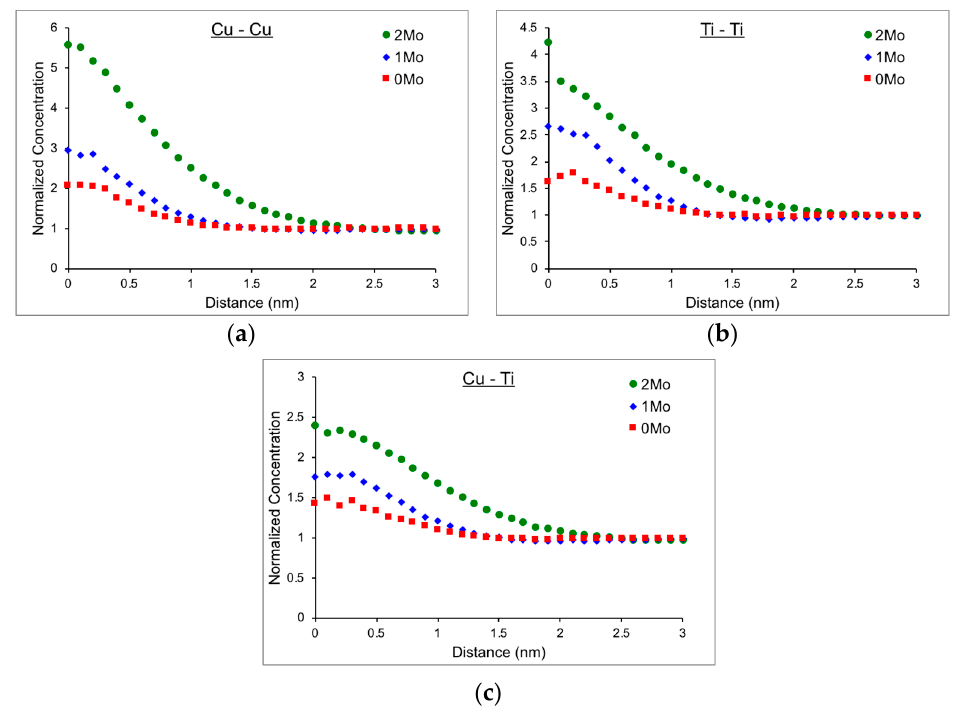
Figure 2. Normalized radial distribution function (RDF)-curves from atom probe tomography (APT) analysis after aging at 475 °C for 5 min: ( a ) Cu-Cu; ( b ) Ti-Ti; ( c ) Cu-Ti. The first element refers to the center atom and the second to the element for which the RDF is shown.